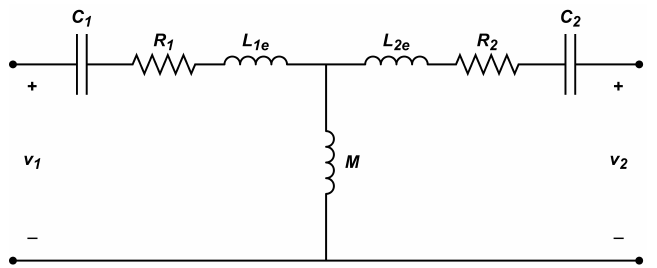
Figure 4. T-model employed for the magnetic